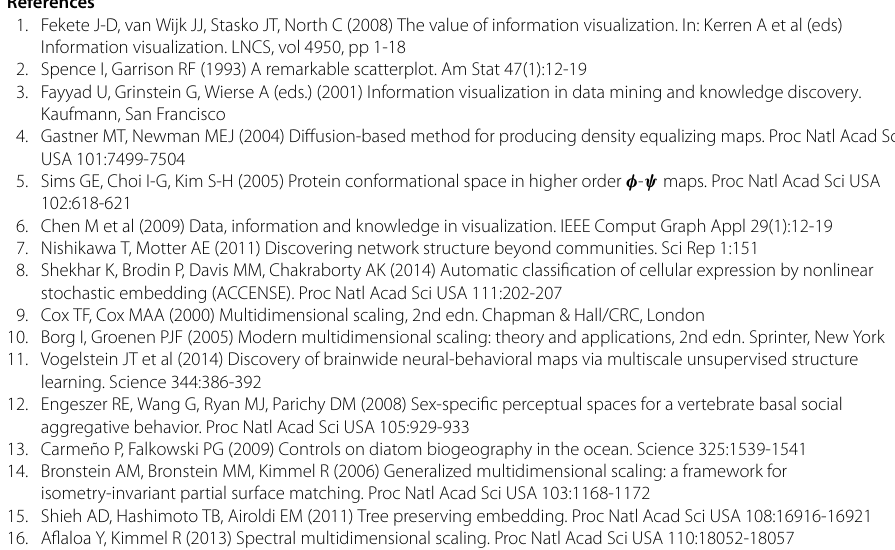
and w ( x ) , replacing n by n ij . ij ij and w ( y ) ij ij